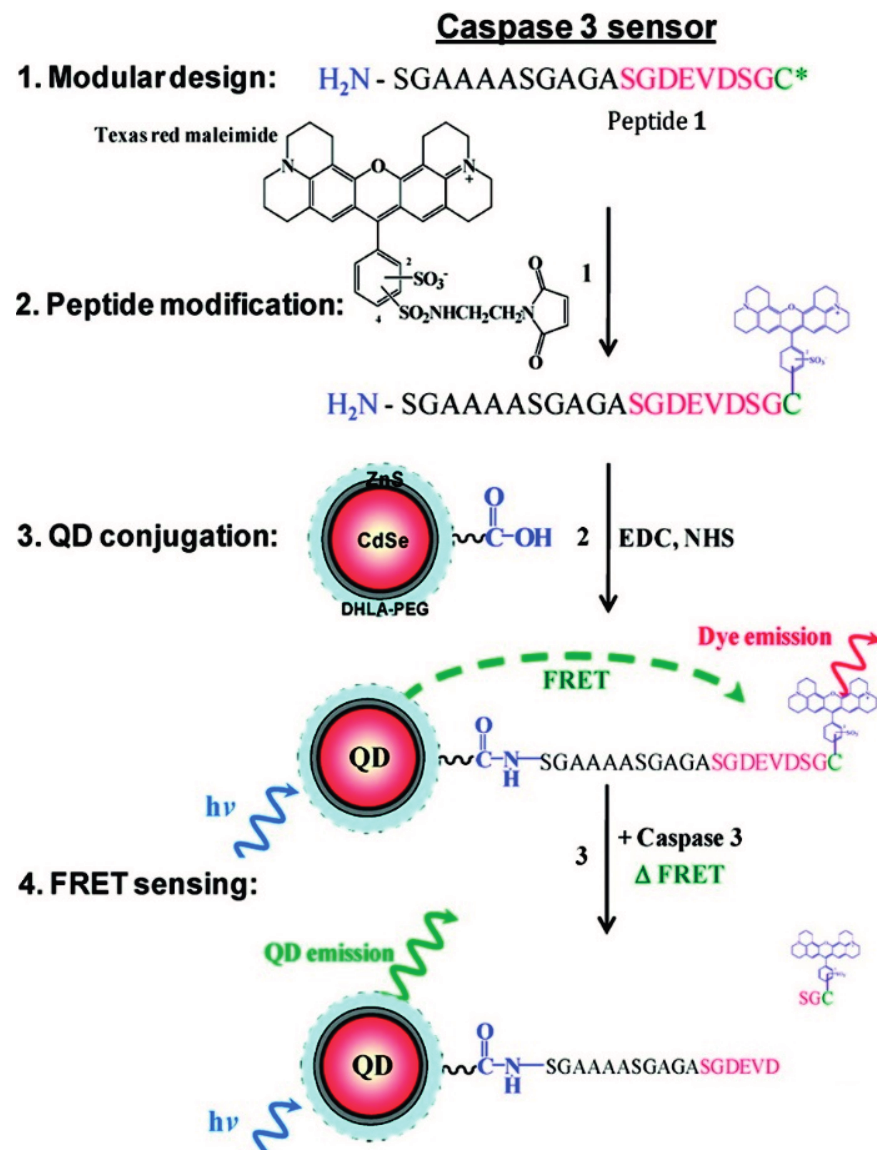
Figure 3. Schematic of the caspase 3 sensor design and response mechanism (Reprinted with permission from [76], Copyright 2010 American Chemical